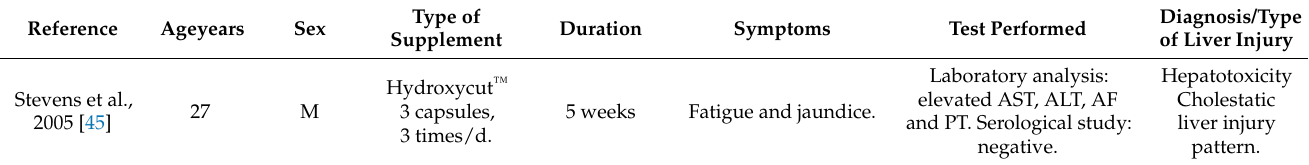
Table 2. Cases of liver damage associated with the consumption of Garcinia cambogia supplements in humans.